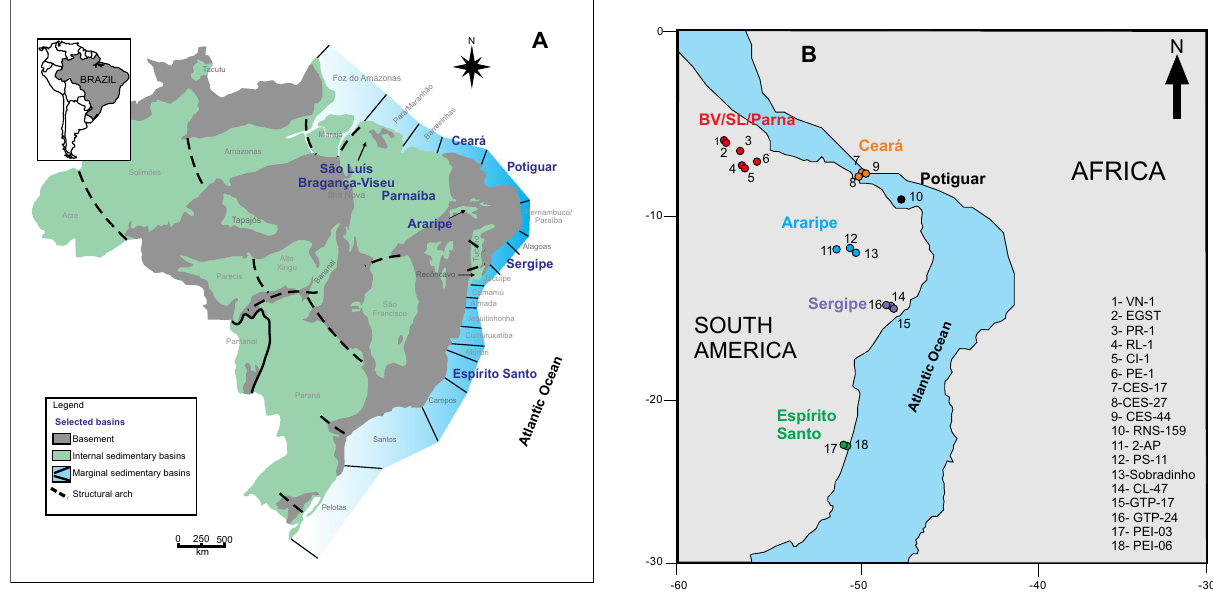
Figure 1. Location of sedimentary basins and stratigraphic sections in Brazil. ( A ) Map showing Brazilian sedimentary basins. The figure was created by Freehand MX (https:// www. adobe. com/ mena_ en/ produ cts/ freeh and/). ( B ) Paleogeographic setting of the late Aptian showing the sites of stratigraphic sections. The Reconstruction map at 116 Ma was generated by ODSN Plate Tectonic Reconstruction Service (https:// www. odsn. de/ odsn/ servi ces/ paleo map/ paleo map.